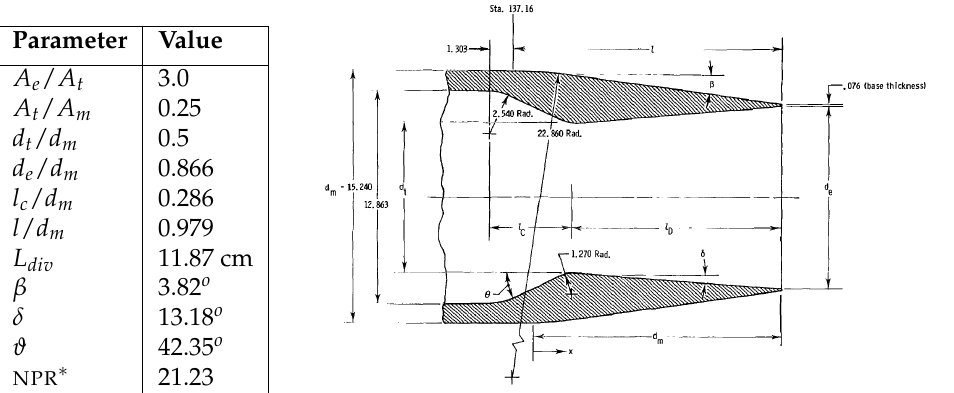
Figure 2. Nozzle Configuration-2 (adapted from Ref. [27]). Geometry and e list of relevant design